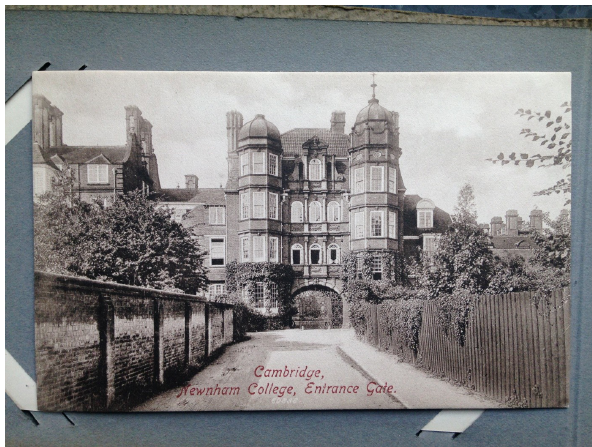
Figure 2. Newnham College (Inge Lehmann Collection, The Dan- ish National